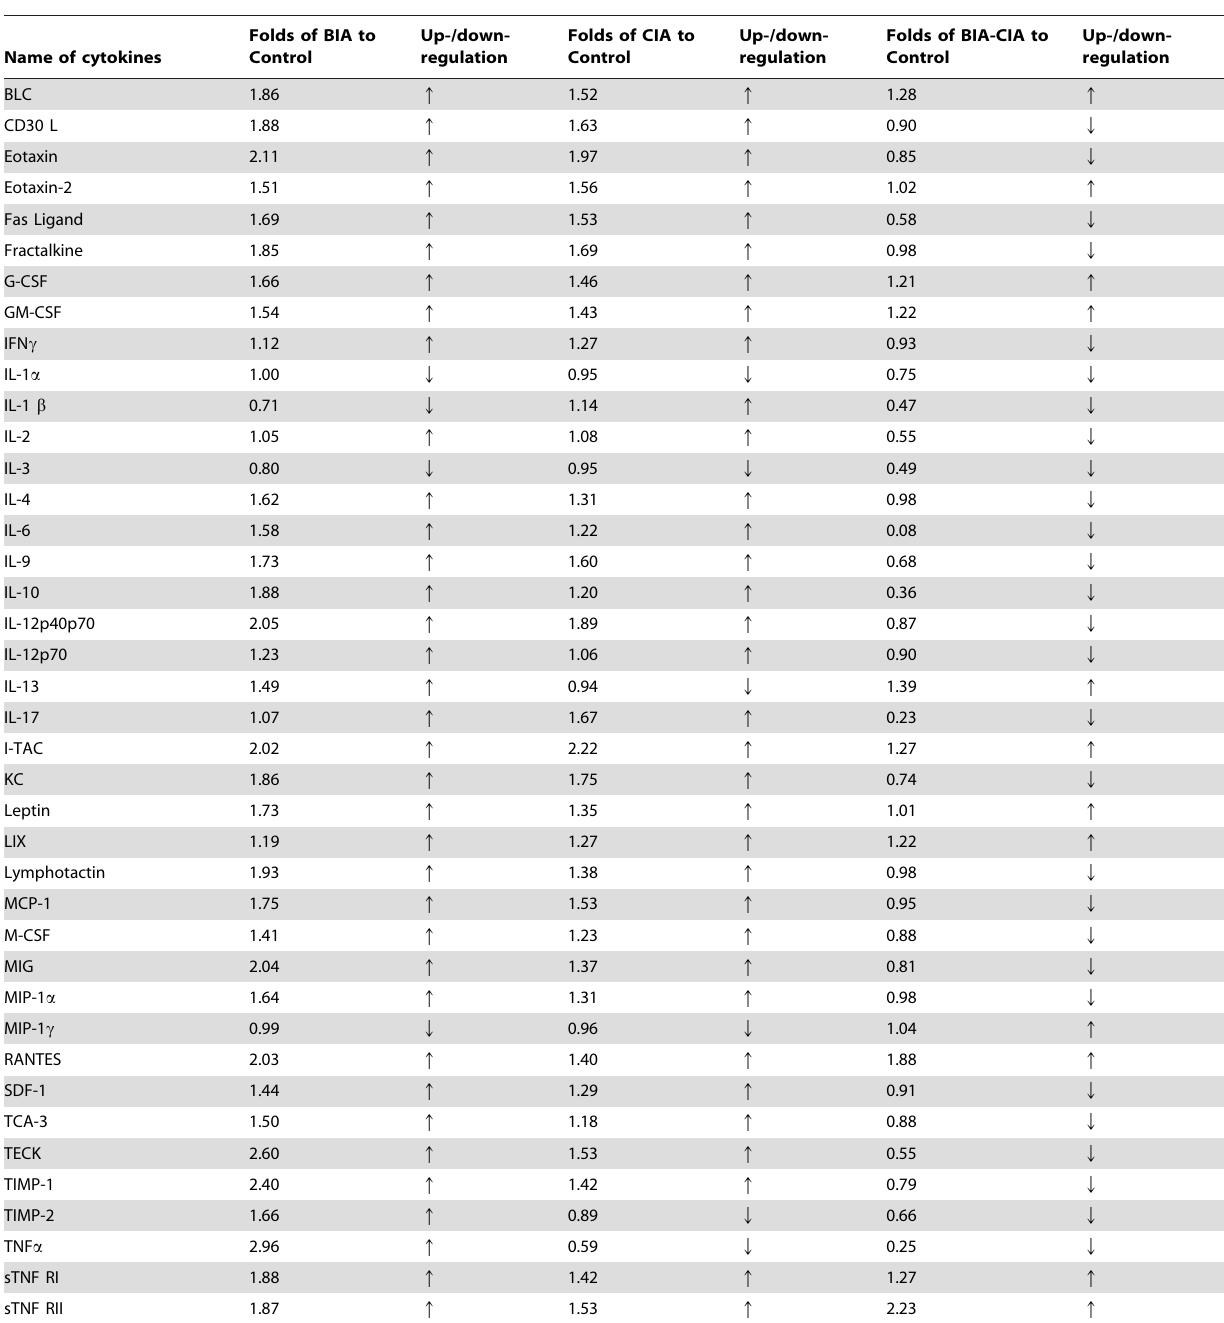
Table 2. Global modulation of inflammation-related cytokines in blood of BIA, CIA and BIA-CIA mice.